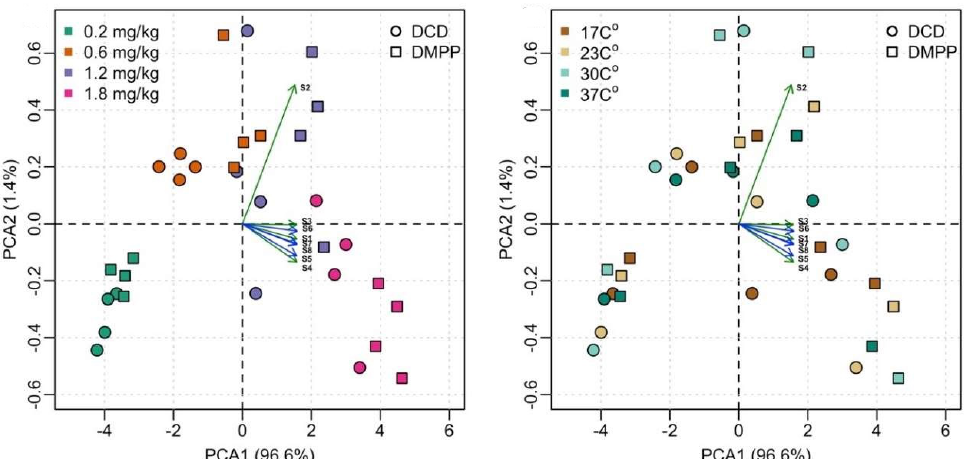
Figure 5. Biplot of PCA1 vs. PCA2 corresponding to a full-data principal component analysis (PCA) for inhibitory effect (IE) of DCD and DMPP in cropped and non-cropped soils. (S1, S2, S3, S4 represent soil samples collected from non-cropped fields and S5, S6, S7, and S8 represent soil samples collected from cropped fields in Chiayi, Taoyuan, Miaoli, and Pingtung, respectively).